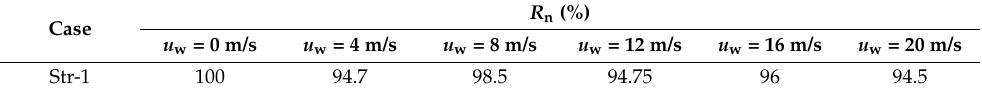
Table 4. The ratios of the rotational speed of leeward fans for Str-1 cases at various wind speeds.